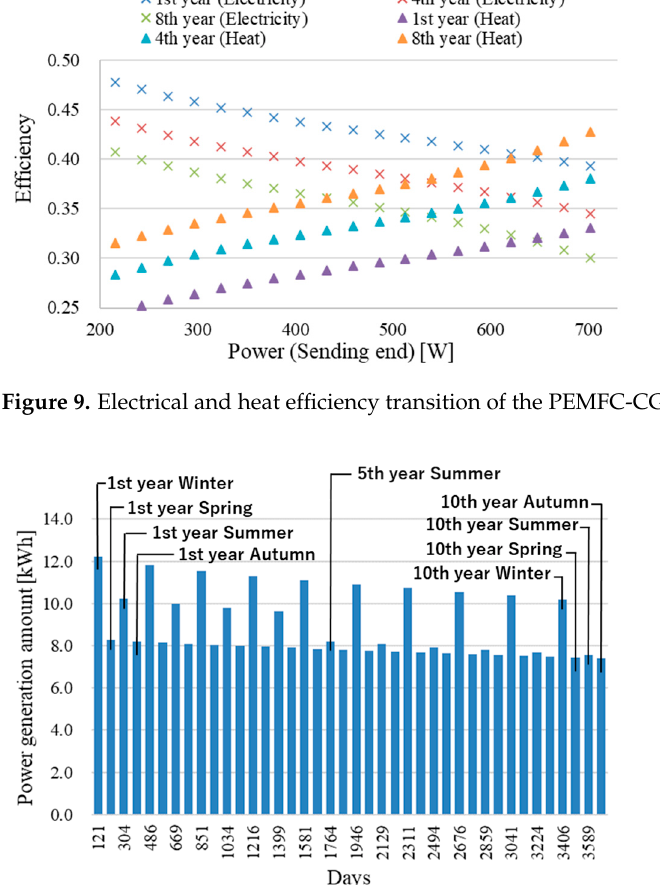
Figure 10. Transition of the PEMFC’s power generation amount per